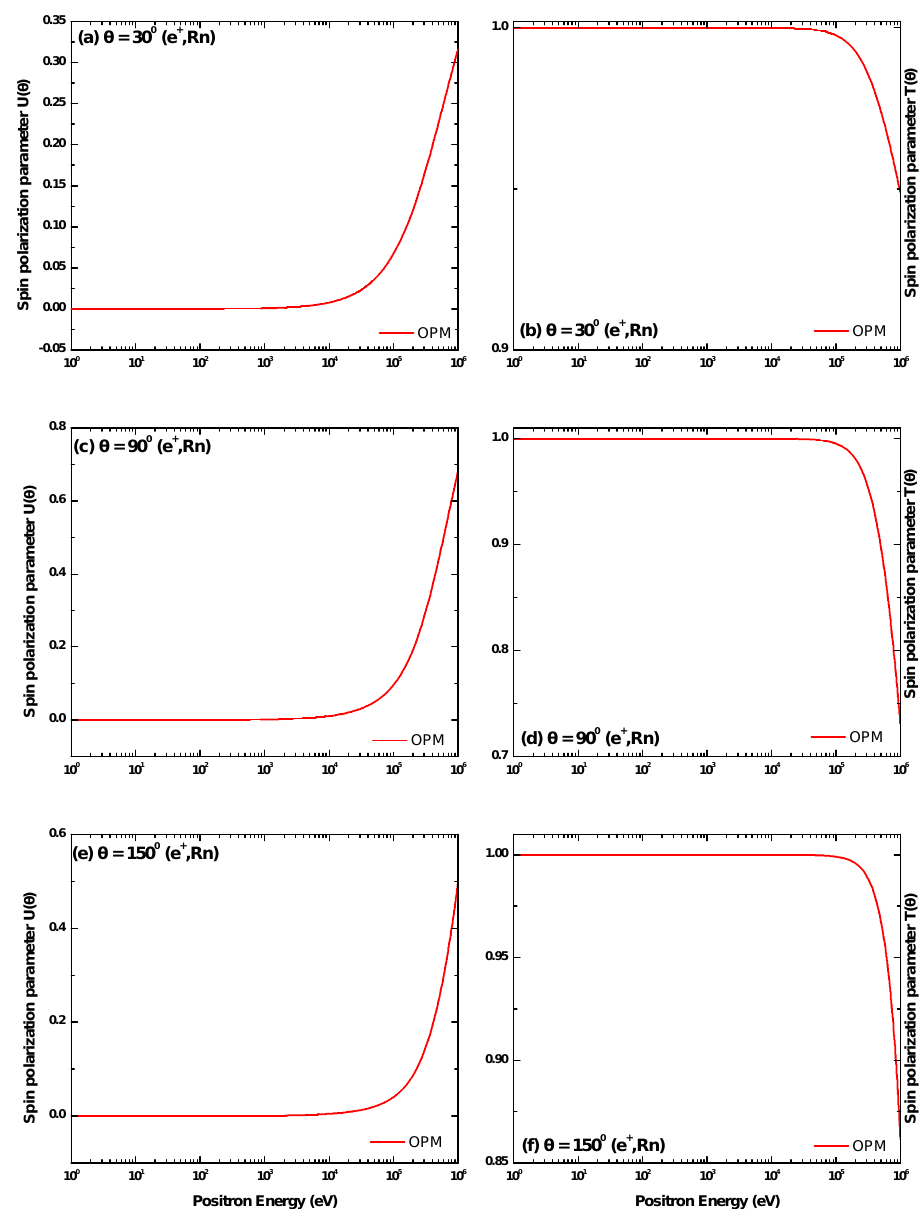
Figure 24. Energy dependence of the spin polarization parameters U and T for positrons elastically scattered from neutral radon atoms at scattering angles ( a , b ): 30 ◦ , ( c , d ): 90 ◦ and ( e , f ): 150 ◦ . For e + - 222 Rn scattering, the present results of IECS, MTCS, VCS, INCS and TCS calculated for 1 eV ≤ E i ≤ 1 MeV are presented in Figure 25. It is noticeable that all these results are considerably different in values and shape from their electron counterparts. The magnitude of these cross sections is two to three times smaller than those due to electron scattering. Regarding the shape, on the other hand, some structures are clearly visible in IECS, MTCS and VCS curves for electron scattering, whereas they are very shallow in the case of positron scattering. These variations certainly support the fact that the e + - 222 Rn interaction is rather weaker as compared to its electron counterpart. It is worth mentioning that the interaction potentials involved in these two projectiles are drastically different. In the case of positron projectile, the static potential ( V st ) is repulsive and the exchange potential ( V ex ) is absent as opposed to the electron projectile. Moreover, the polarization potential of the short range parts also different for both the